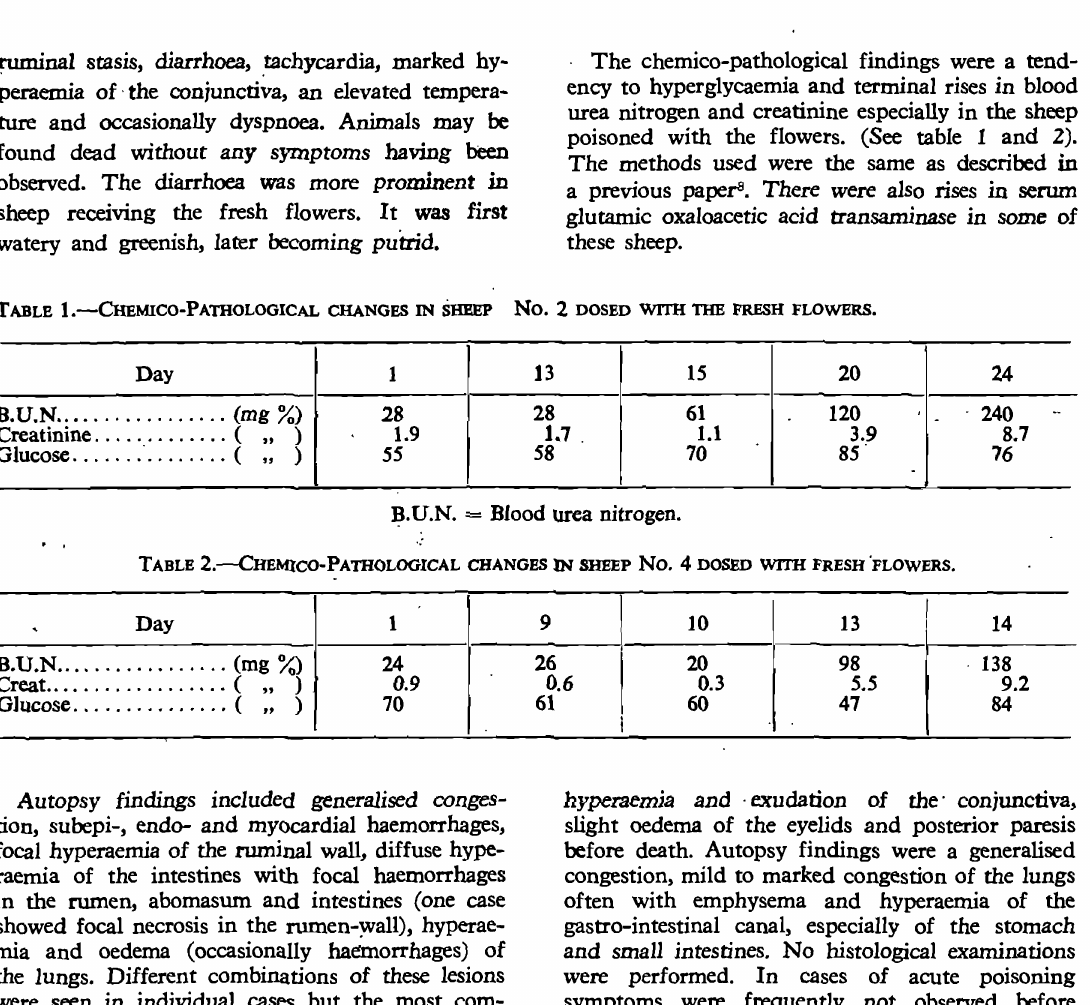
TABLE 1.-CHEMICO-PAmOLOGICAL CHANGES IN SHEEP No.2 DOSED WITH mE FRESH FLOWERS.